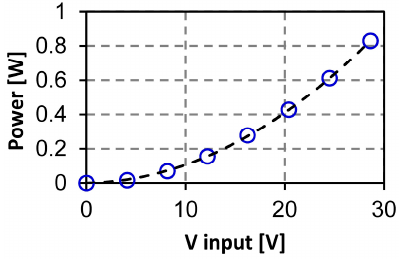
Figure 6. The consumed power as a function of the input voltage of one typical device.